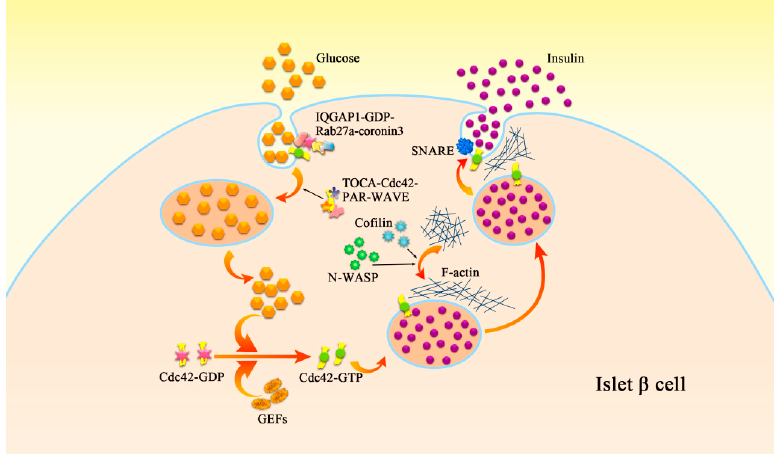
Figure 1. The mechanism of glucose-induced insulin secretion in islet β cell. GEFs exchange Cdc42-GDP (inactive) into Cdc42-GTP (active) which can be transported to the cell membrane, this process could be also promoted via glucose. Then activated Cdc42 is localized with insulin secretory granules and subsequently induces mobilization of insulin granules moving to the plasma membrane via rearrangement of F-actin, which could be rearranged via N-WASP and Cofilin as well. Positioning and fusion between granules and cell membrane are regulated by SNARE on cell membrane, and also by the F-actin rearranged by Cdc42. Glucose stimulates exocytosis as well as endocytosis of secretory membrane. Cdc42 is involved in the formation of a complex among IQGAP1, GDP-bound Rab27a, and coronin 3. This complex is essential for endocytosis of the insulin secretory membrane. Besides, a TOCA/Cdc42/PAR/WAVE complex contributes to endocytosis and is required for retrograde endocytic recycling.